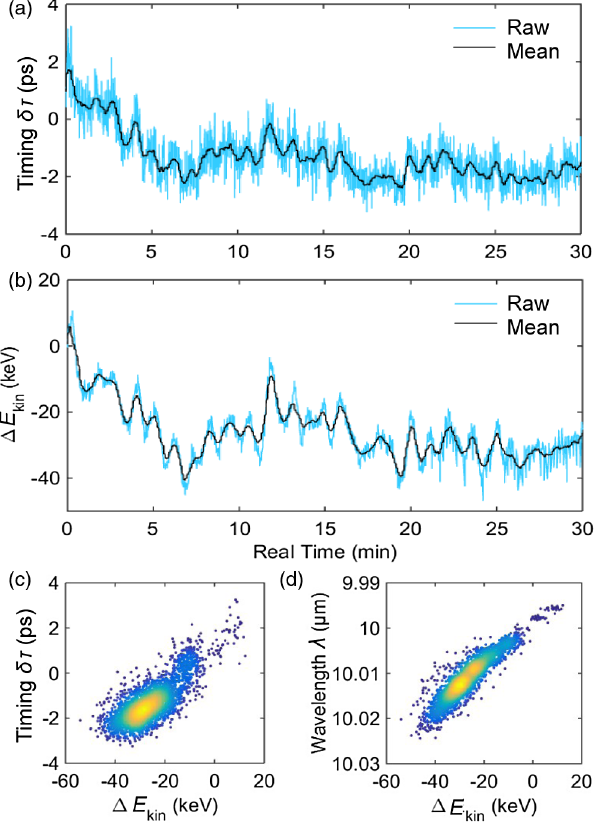
FIG. 3. Drift of FEL pulse timing and electron energy. (a) Micropulse timing fluctuations δτ measured by calibrated BOC (blue curve) and moving average with half-minute window (black curve) and (b) corresponding changes in kinetic energy Δ E of electron bunches as determined by beam-position kin ¼ 36 . 5 MeV. In monitoring. Nominal electron energy is E kin ; 0 (c) and (d), the correlation of the raw data is shown by scatter plots with color indicating data density (blue low, yellow high). The calculated (Pearson) correlation coefficient ρ is 0.78 and 0.92 between kinetic energy vs micropulse timing (c), and FEL radiation wavelength (d),